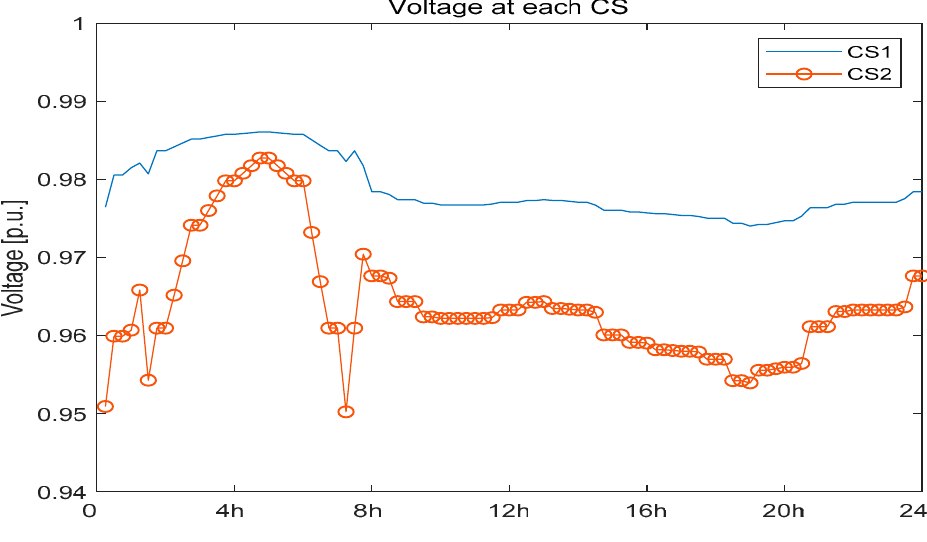
Figure 11. Voltage of CSs in Case 2.